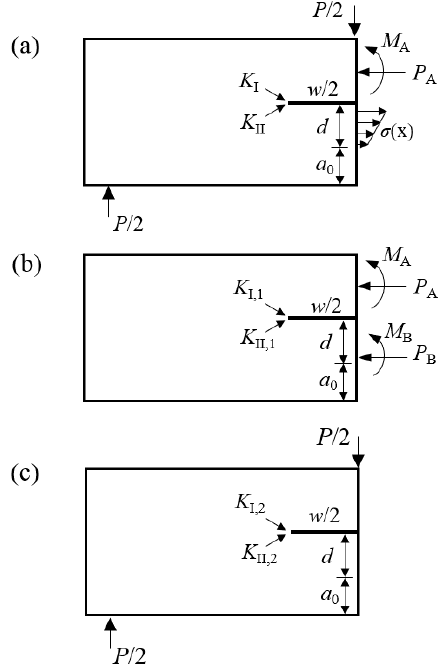
Figure 14. Calculation of the stress intensity factor (SIF) of the preset crack tip. ( a ) The load applied on the half concrete beam; ( b ) The force generating stress intensity factor K I,1 and K I,2 ; ( c ) The force generating stress intensity factor K I,2 and K II,2.